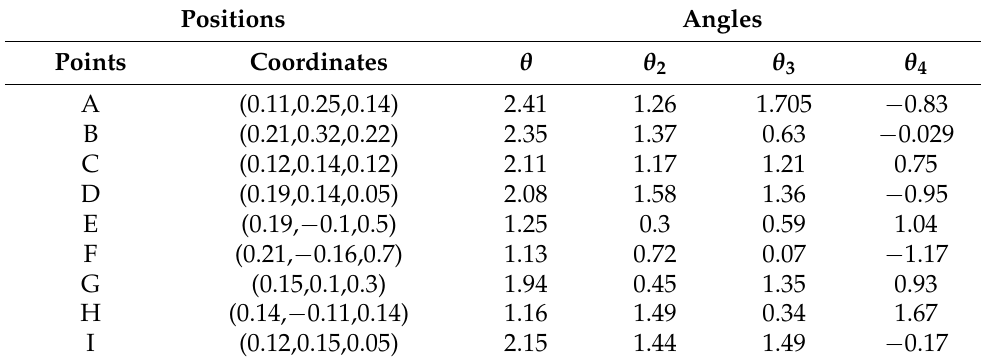
Table 5. Coordinates and angles of the target